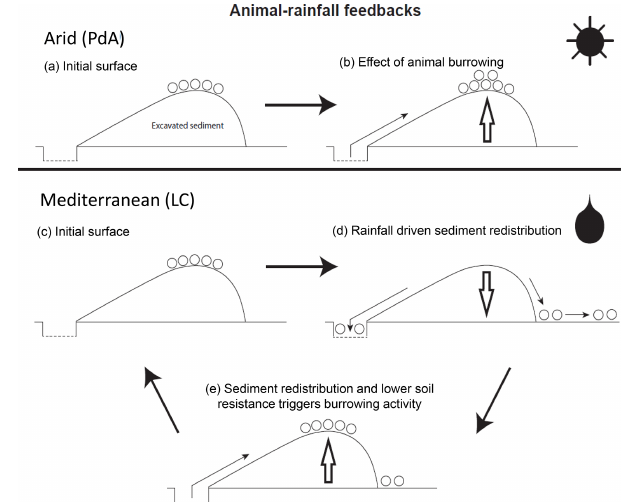
Figure 9. Scheme of animal-driven and rainfall-driven sediment redistribution processes in both investigated climate zones. Panel (a) describes the initial surface of the burrow before the start of a sediment redistribution process, and panel (b) describes the animal excavation process in the arid climate zone. Here, due to rarely oc- curring rainfall events, sediment redistribution is mostly controlled by the animal burrowing activity. Panel (c) describes the initial burrow surface in the Mediterranean climate zone, panel (d) de- scribes the process of sediment redistribution during a rainfall event, and panel (e) describes the subsequent animal burrowing activity. Burrowing is triggered by decreased soil resistance due to the in- creased soil moisture after rainfall and by sediment accumulation within the burrow’s entrance. Burrowing activity leads to a new sup- ply of sediment being excavated to the surface. In the Mediterranean climate zone, sediment redistribution is controlled by both animal burrowing activity and rainfall. The alternating excavation and ero- sion processes ultimately lead to an increase in redistribution rates.